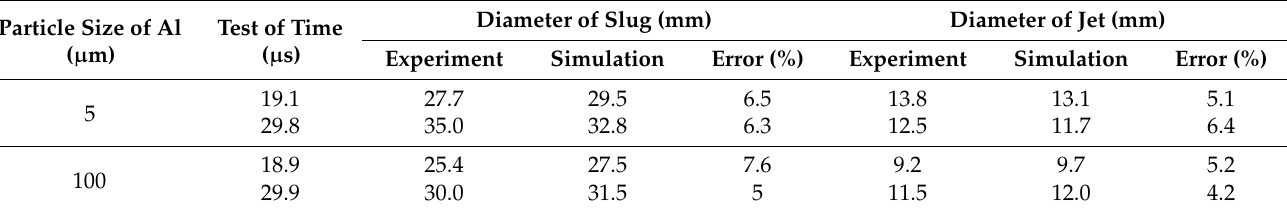
Table 5. The size of reactive jet.